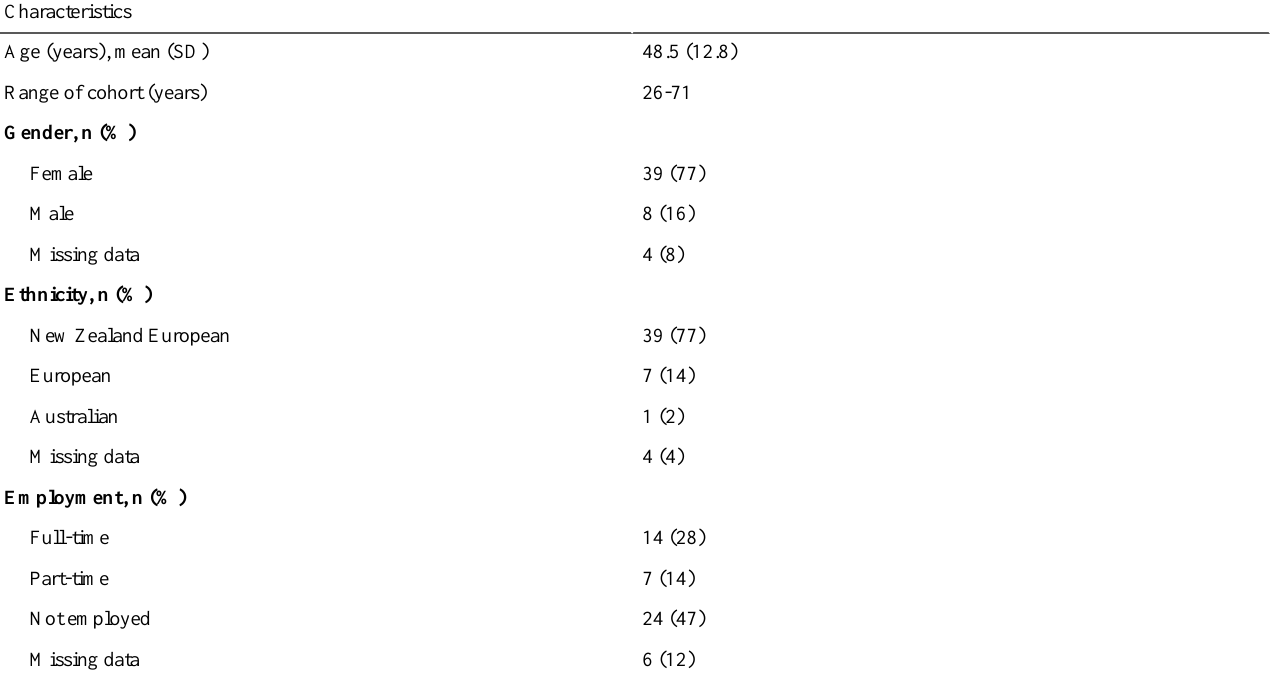
Table 1. Demographic characteristics of participants